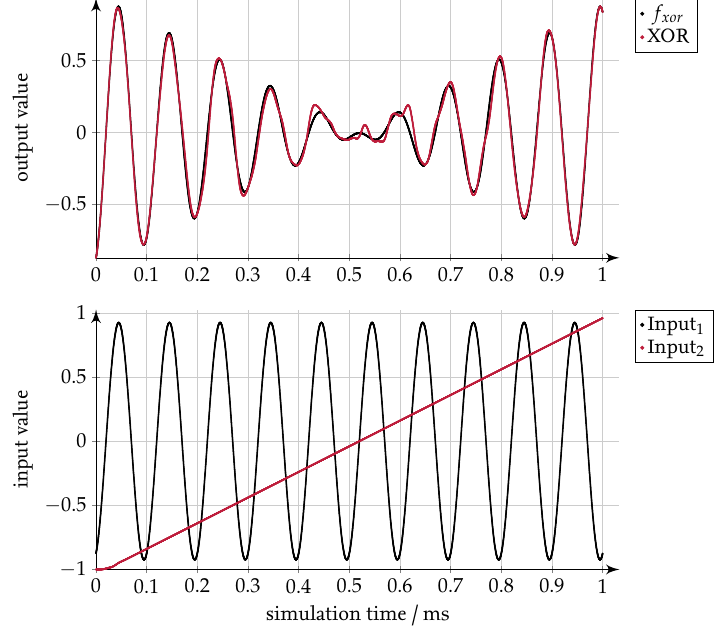
x 1 x 2 and f and = x 1 x 2 . − · ·